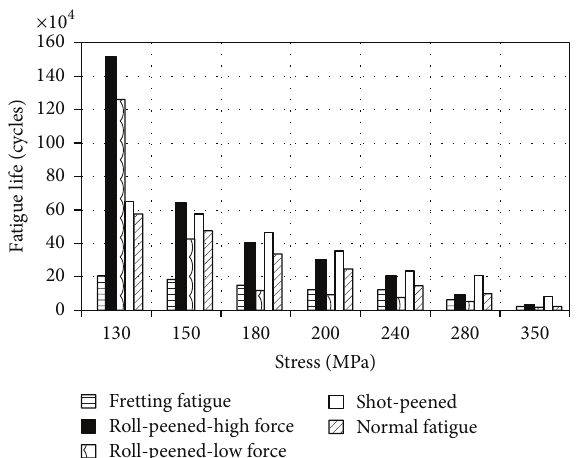
Figure 8: Bar chart for various fatigues testing conditions [38].